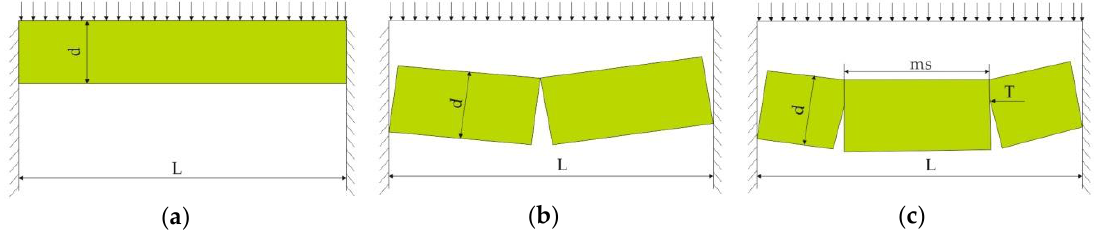
Figure 5. Safety factors for roof layers: ( a ) Continuous; ( b ) Two-span discontinuous; ( c ) Three-span discontinuous; d - layer thickness, L – layer span; ms - length of the middle block; T - axial force.